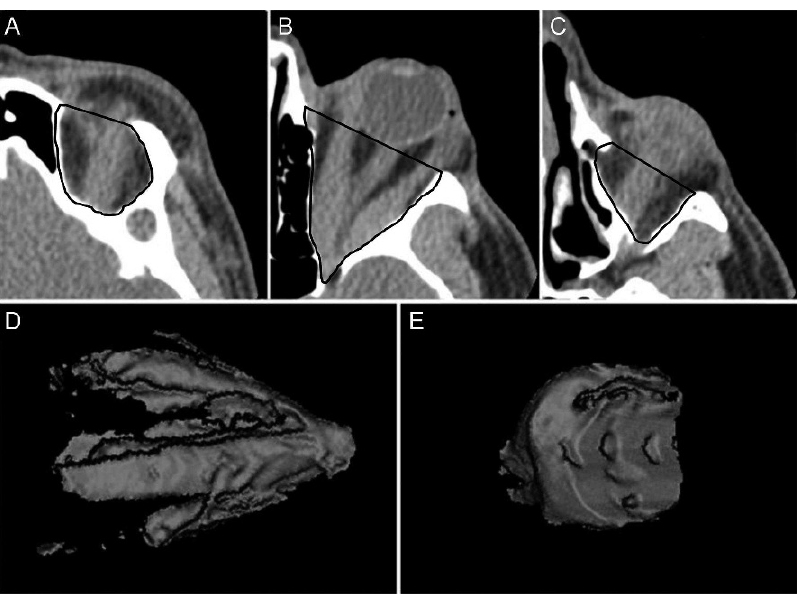
Figure 1 - A, B and C. Examples of the area outlined on 3 axial slices of computed tomography scans, from which measurements were obtained. Representation of the soft tissue (mostly muscles; D) and orbital fat (E) volumes based on measurements of the sequential axial slices.